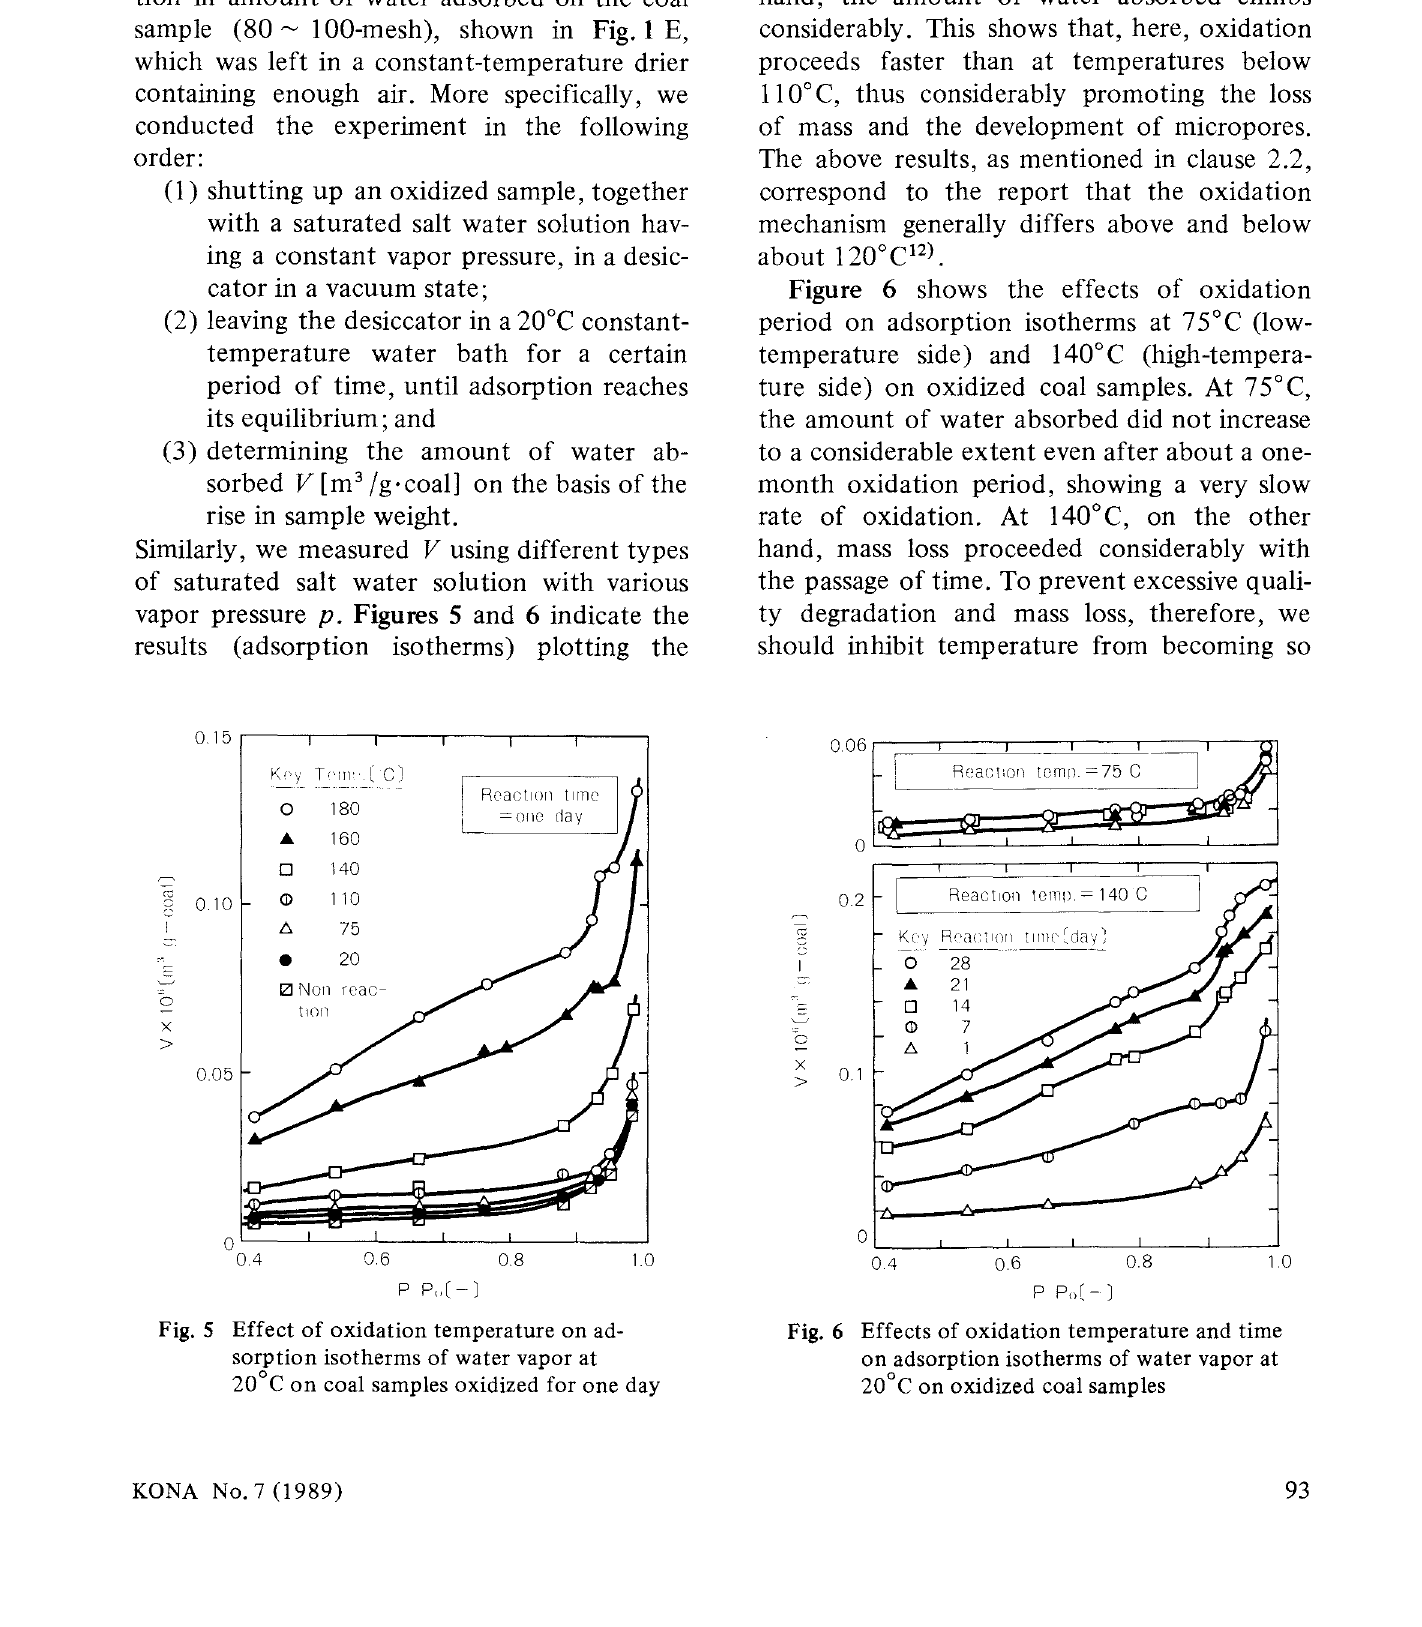
Fig. 6 Effects of oxidation temperature and time on adsorption isotherms of water vapor at 20°C on oxidized coal